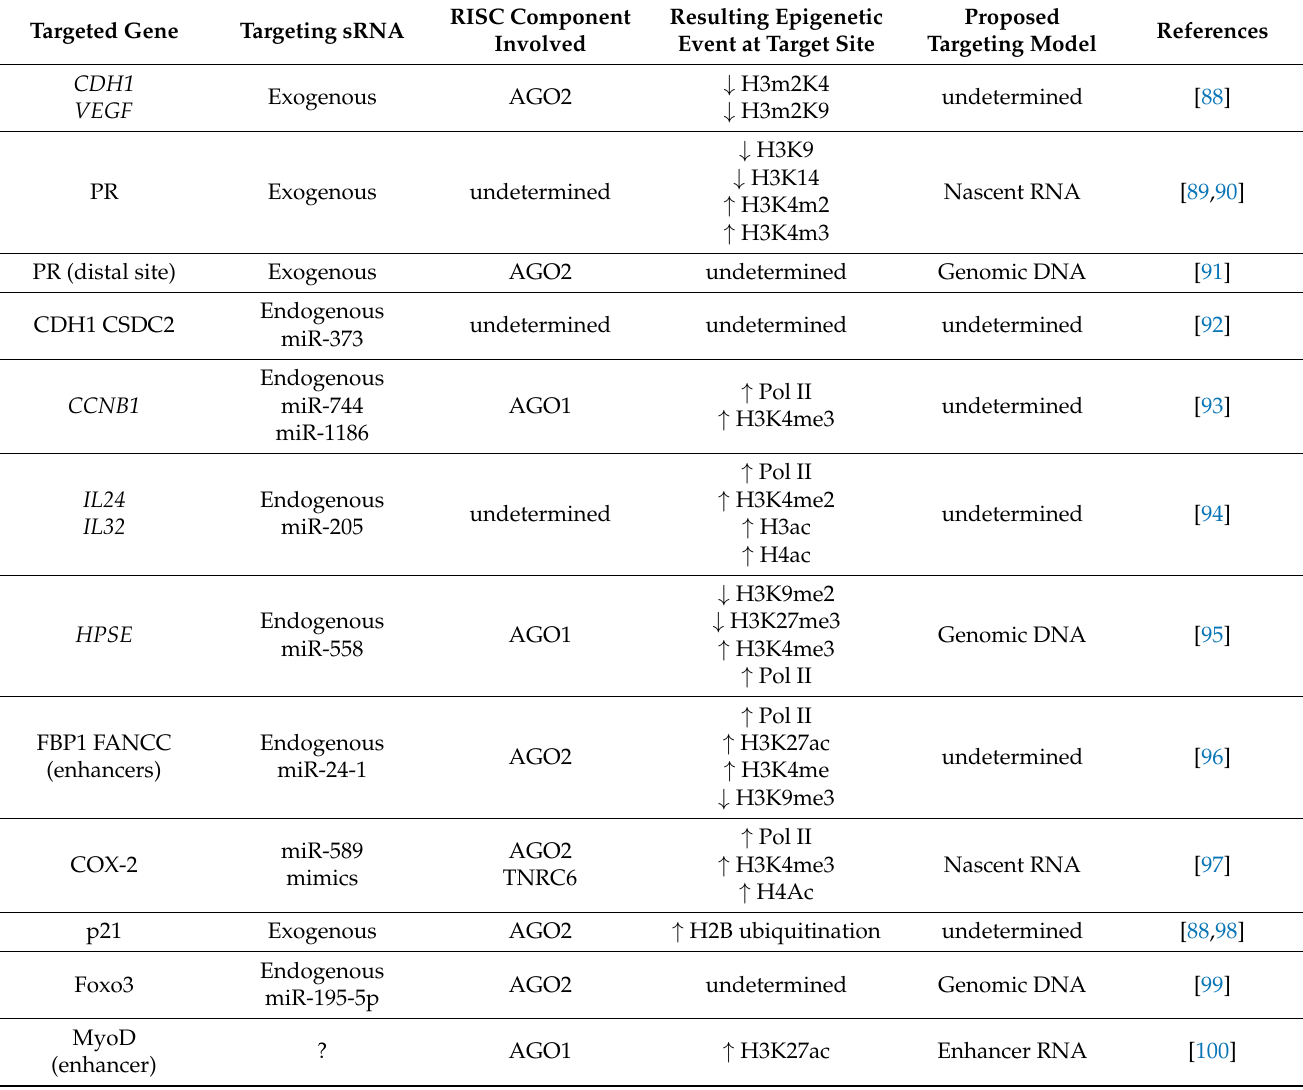
Table 2. Summary of studies showing genes regulated by TGA mechanisms in mammals. In the listed examples, the region targeted by the small RNA falls within the promoter of the gene, unless stated